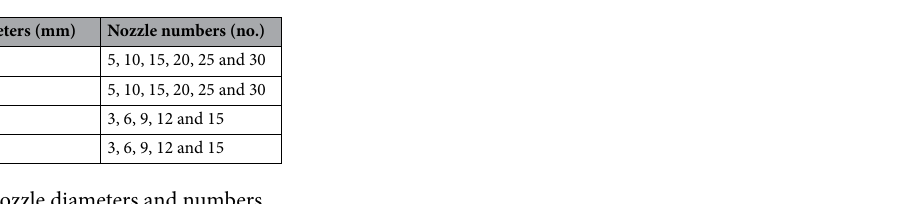
Table 1. Nozzle diameters and